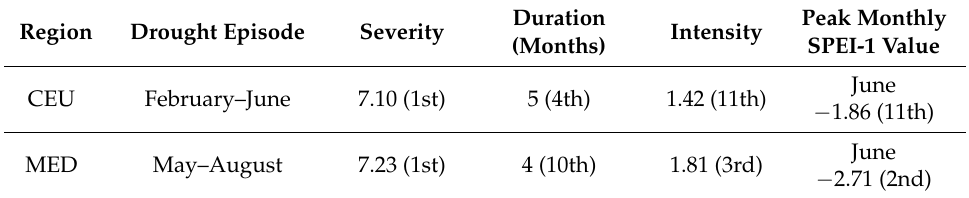
Figure 4. Time series of Standardised Precipitation Evapotranspiration Index for one month (SPEI-1) over the Central European region ( top panel ) and Mediterranean region ( bottom panel ) during 1980–2015. Positive values are in blue and negative values are in red. The black rectangles show the development of the drought episode over the Central European and Mediterranean regions during 2003. Table 2. Characteristics of the 2003 drought episode that occurred over the Central Europe region (CEU) and the Mediterranean region (MED). The number in parenthesis indicates the rank occupied by the episode in comparison to the other episodes identified over the respective region during 1980–2015. For the peak monthly Standardised Precipitation Evapotranspiration Index for one month (SPEI-1) values, the lowest value observed in the 36-year monthly SPEI-1 time series occupies the first rank